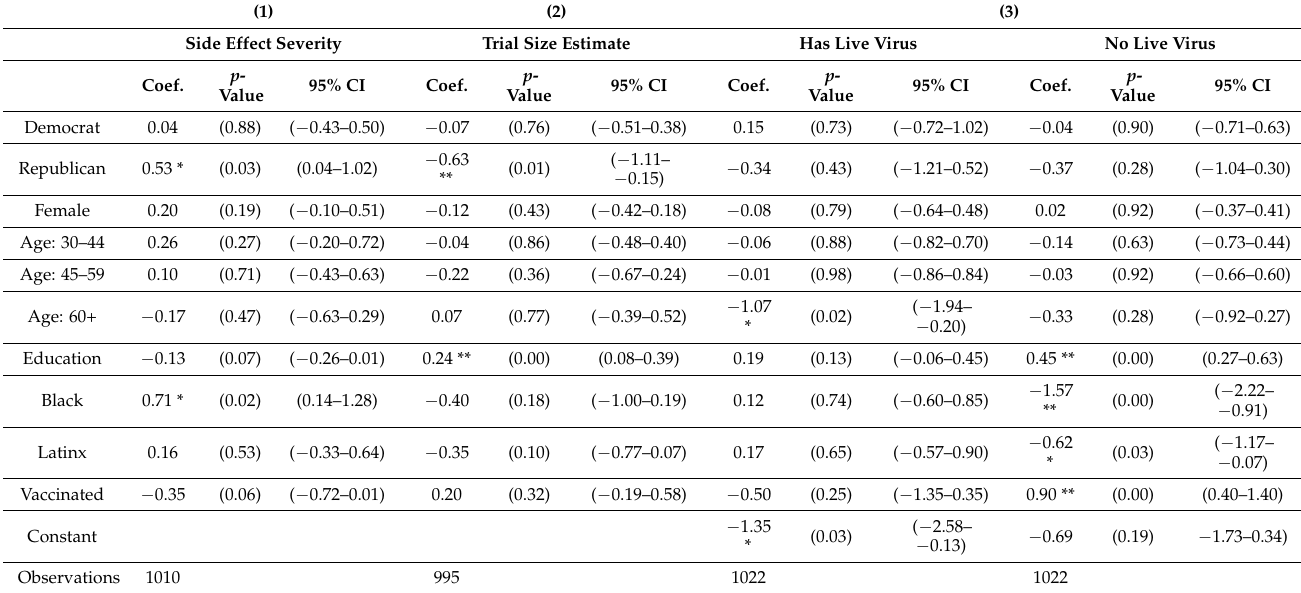
Table 2. Factors associated with clinical trial size estimates, beliefs vaccine contains live coronavirus, and perceived side effect